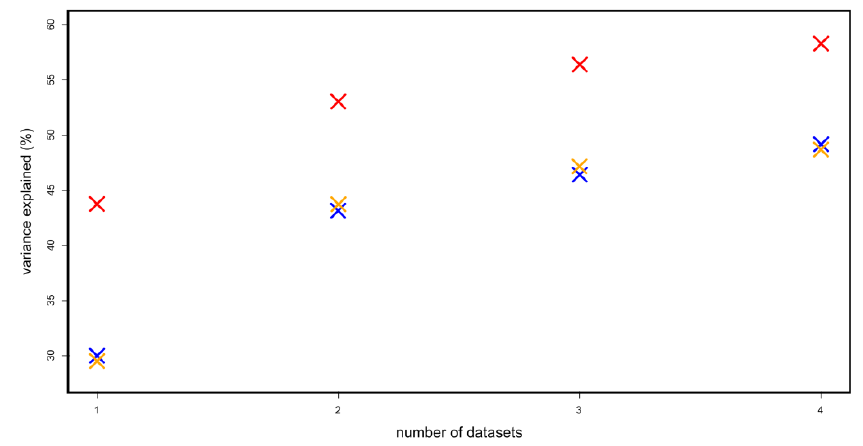
Figure 3. The percentage of variance explained for three smaller subsets of SAR